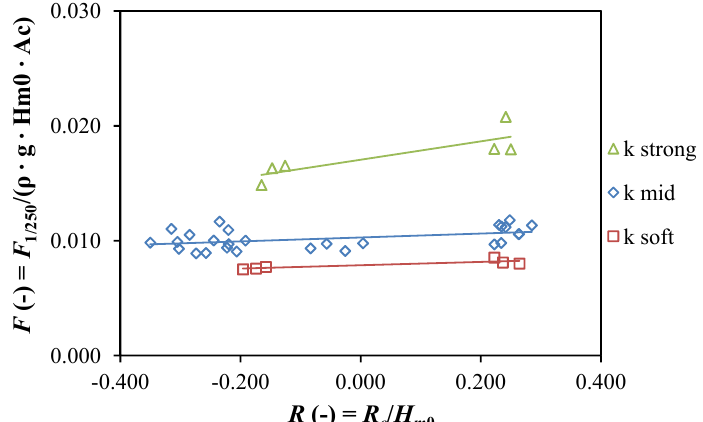
Figure 6. Effect of the non-dimensional crest level, R (-), and of the mooring compliance on the non-dimensional extreme tension in the main mooring line, F